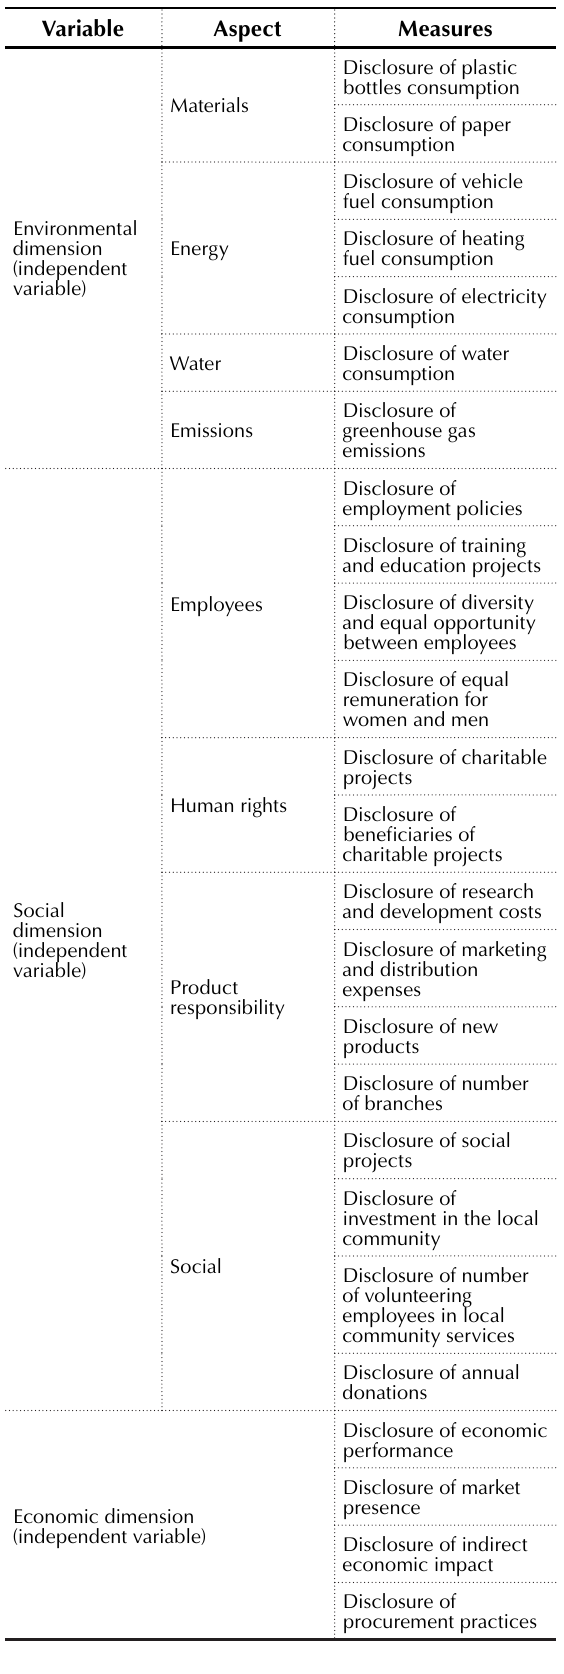
Table 2. Sustainability accounting